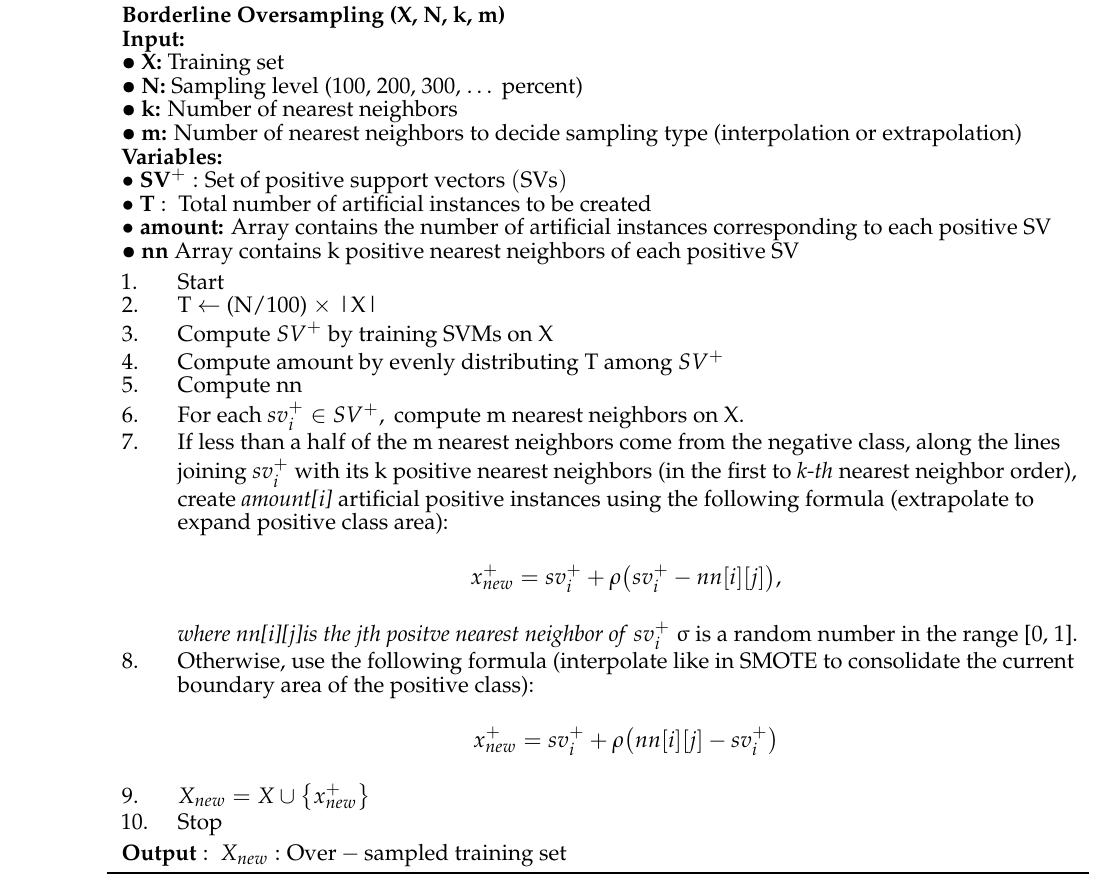
Algorithm 5: Pseudo code of